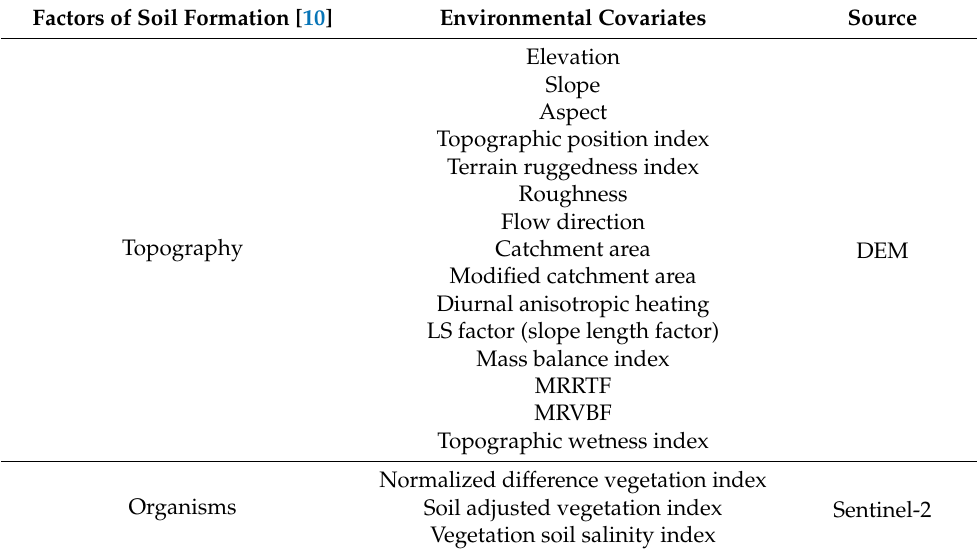
Table 1. Cont. Factors of Soil Formation